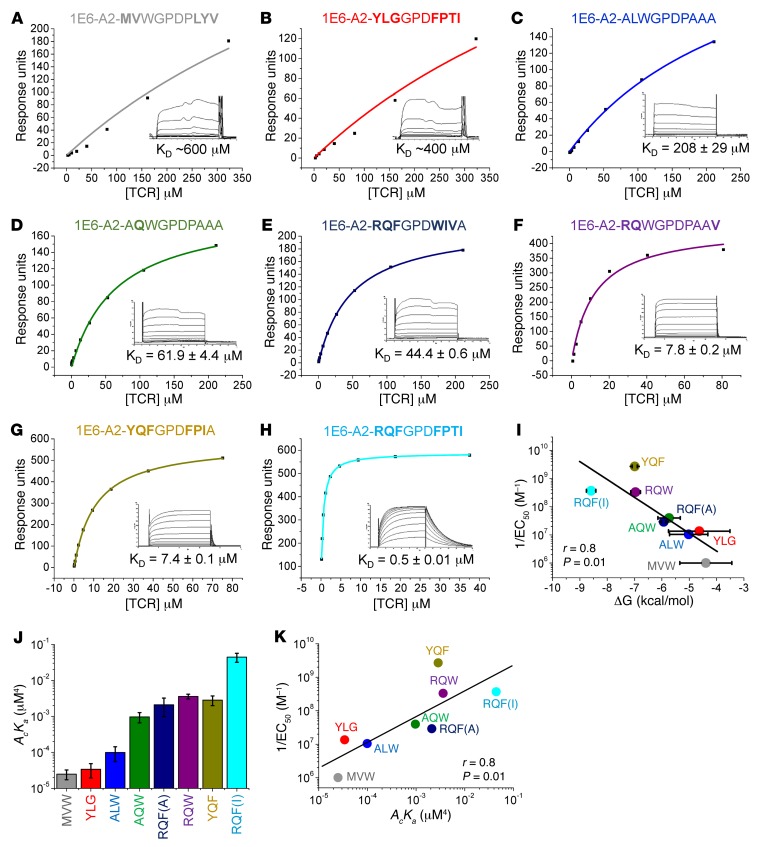
3D and 2D binding analysis of the 1E6 TCR with A2-ALW and the APLs.(A–H) Binding affinity of the 1E6 TCR interaction at 25°C using SPR. Eight serial dilutions of the 1E6 TCR were measured (shown in the inset); representative data from 3 independent experiments are plotted. The equilibrium binding constant (KD) values were calculated using a nonlinear curve fit (y= [P1x]/[P2 + X]). In order to calculate each response, the 1E6 TCR was also injected over a control sample (HLA-A*0201–ILAKFLHWL) that was deducted from the experimental data. (A) 1E6-A2-MVWGPDPLYV (approximate value); (B) 1E6-A2-YLGGPDFPTI (approximate value); (C) 1E6-A2-ALWGPDPAAA; (D) 1E6-A2-AQWGPDPAAA; (E) 1E6-A2-RQFGPDWIVA; (F) 1E6-A2-RQWGPDPAAV; (G) 1E6-A2-YQFGPDFPTA; and (H) 1E6-A2-RQFGPDFPTI. (I) ΔG values, calculated from SPR experiments, plotted against 1/EC50 (the reciprocal peptide concentration required to reach half-maximal 1E6 T cell killing) showing Pearson’s coefficient analysis (r) and P value (including approximate values from A and B). (J) Effective 2D affinity (AcKa) calculated using adhesion frequency assays, using at least 5 cell pairs, and calculated as an average of 100 cell cell contacts. (K) Effective 2D affinity plotted against 1/EC50 showing Pearson’s coefficient analysis (r) and P value.